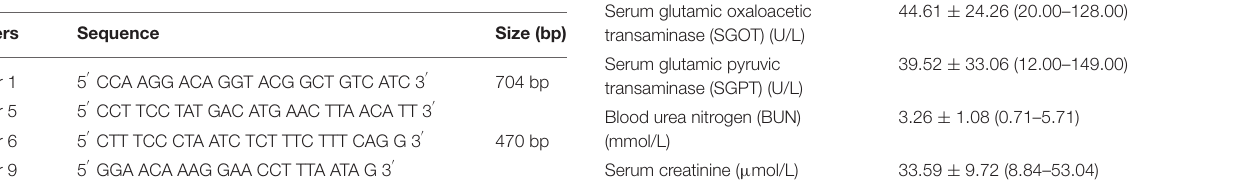
TABLE 1 | Sequence and size of the primers used for DNA amplification (17).